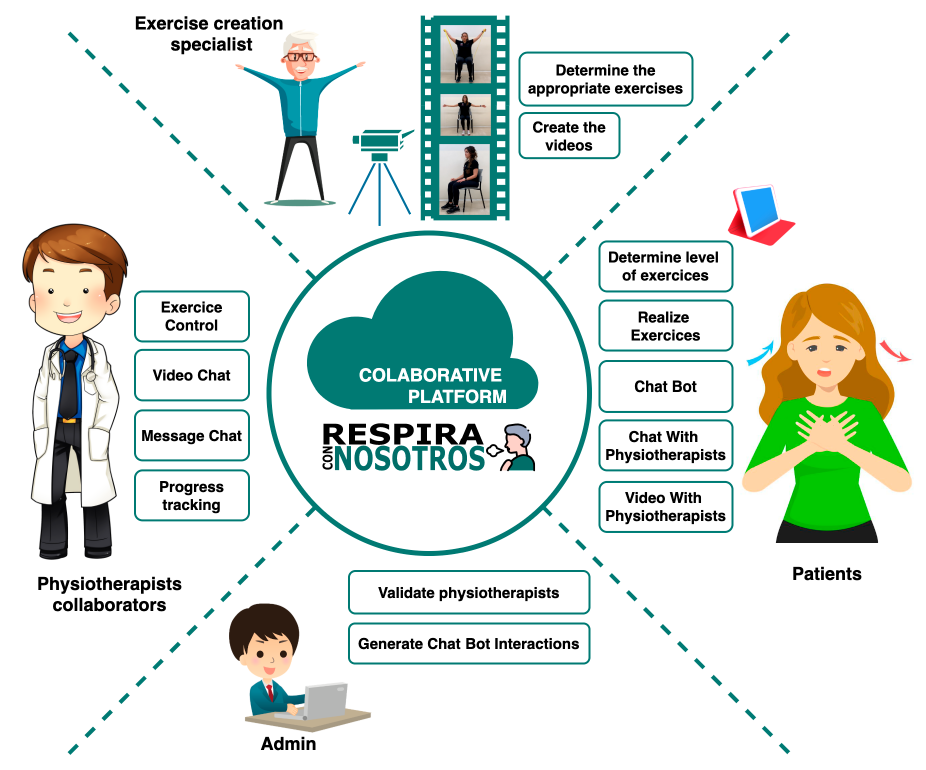
Figure 1. Collaborative platform